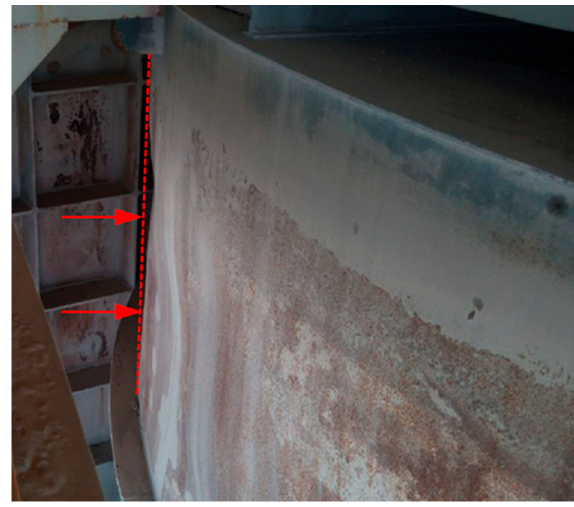
Figure 10. Buckling deformation of the side wall.